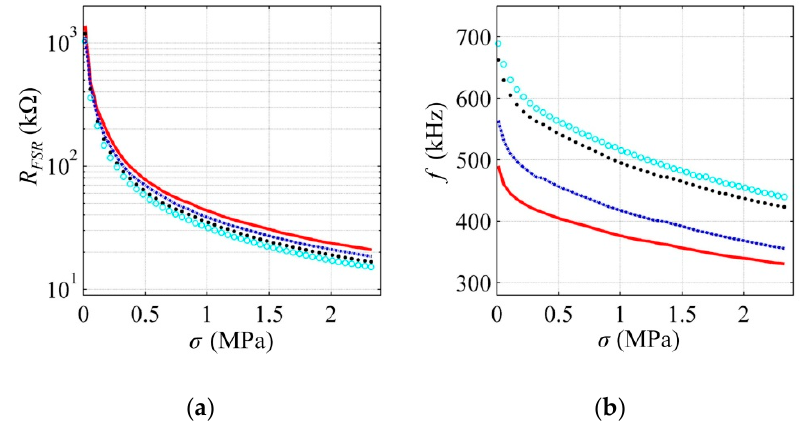
Figure 6. The plots of the sensor’s resistance ( R FSR ) and resulting frequency ( f ) as a function of the applied stress ( σ ) for the FlexiForce A201-25 sensor. ( a ) R FSR measured from the circuit in Figure 5 and Equation (17) at multiple voltages, V FSR = 1.25 V (solid red), V FSR = 2.5 V (dashed blue), V FSR = 3.75 V (black points), V FSR = 5 V (circle cyan); ( b ) f measured from the circuit in Figure 3 with R 1 = R 2 = 2.2 k Ω at multiple sourcing voltages, Vcc = 2.5 V (solid red), Vcc = 3.5 V (dashed blue), Vcc = 4.5 V (black points), Vcc = 5.5 V (circle cyan).